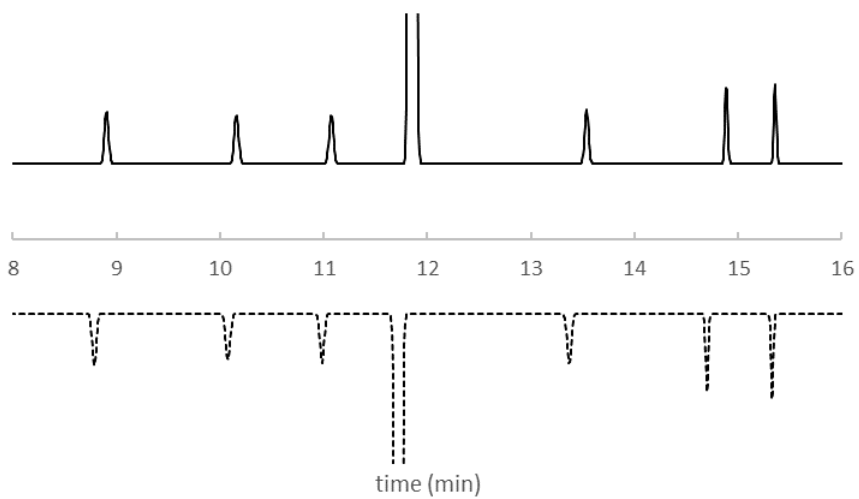
Figure 5. Predicted chromatogram for KPSS components from the retention model built from experimentally determined retention times (RtModel EXP ) (solid line) and the retention model built from QSSR predicted retention times (RtModel QSRR ) (dashed line). Column temperature 40 ◦ C. Gradient profile: Time = 0 min, %B = 15%; Time = 12 min, %B = 45%; Time = 17 min, %B = 95%. See Materials and Methods for other